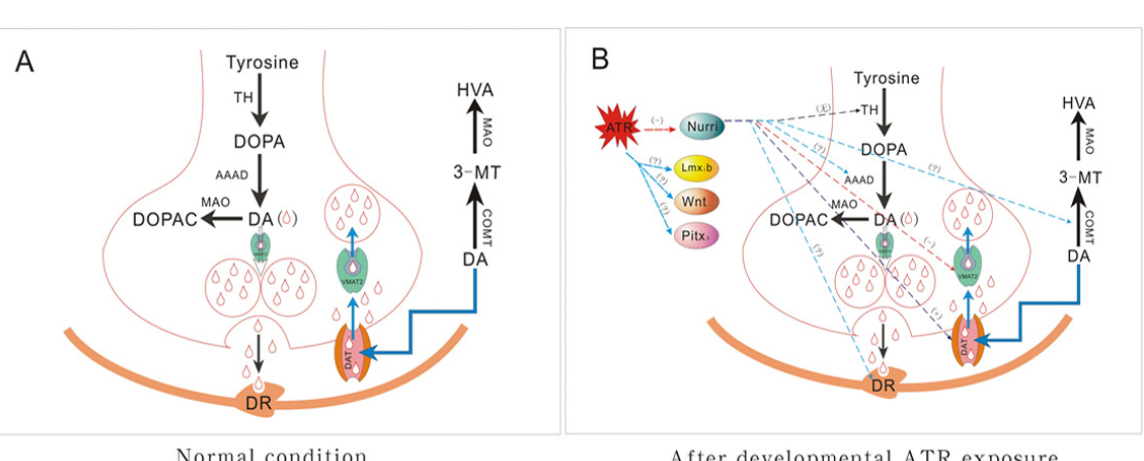
Figure 7. Schematic illustrating the proposed mechanism of developmental ATR exposure on dopaminergic neurons. ATR does not alter the function of TH substantially but can decrease Nurr1 transcription, which can target downstream genes, such as DAT and VMAT2, resulting in the inhibition of vesicular uptake followed by increased cytosolic DA (present study). The effects of ATR on AAAD, MAO, DR, COMT, and Pitx3 remain unknown. ( A : Normal condition; B : After developmental ATR